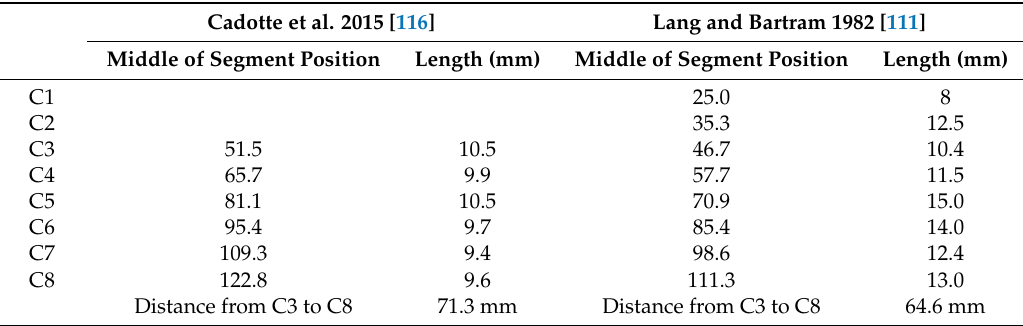
Table 3. Measured cervical spinal cord segment positions in millimeters from the pontomedullary junction (PMJ), and the lengths of each segment, measured based on anatomical MRI (Cadotte et al. 2015) [116] and from cadavers (Lang and Bartram 1982)